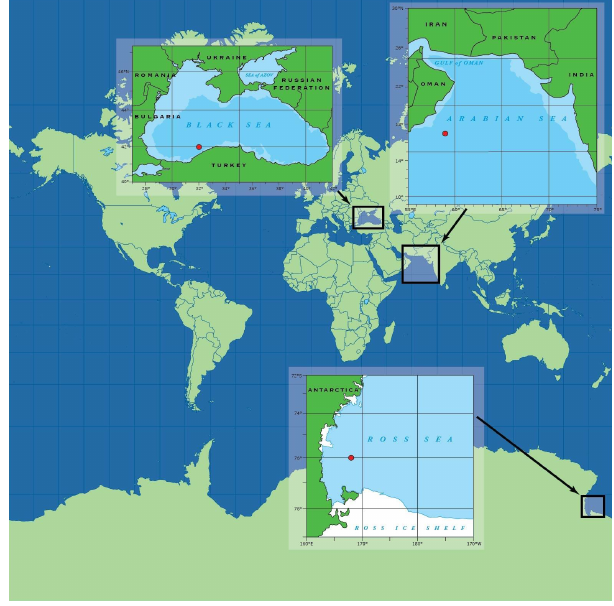
Figure 1. Sampling locations in the Black Sea, Arabian Sea and Ross